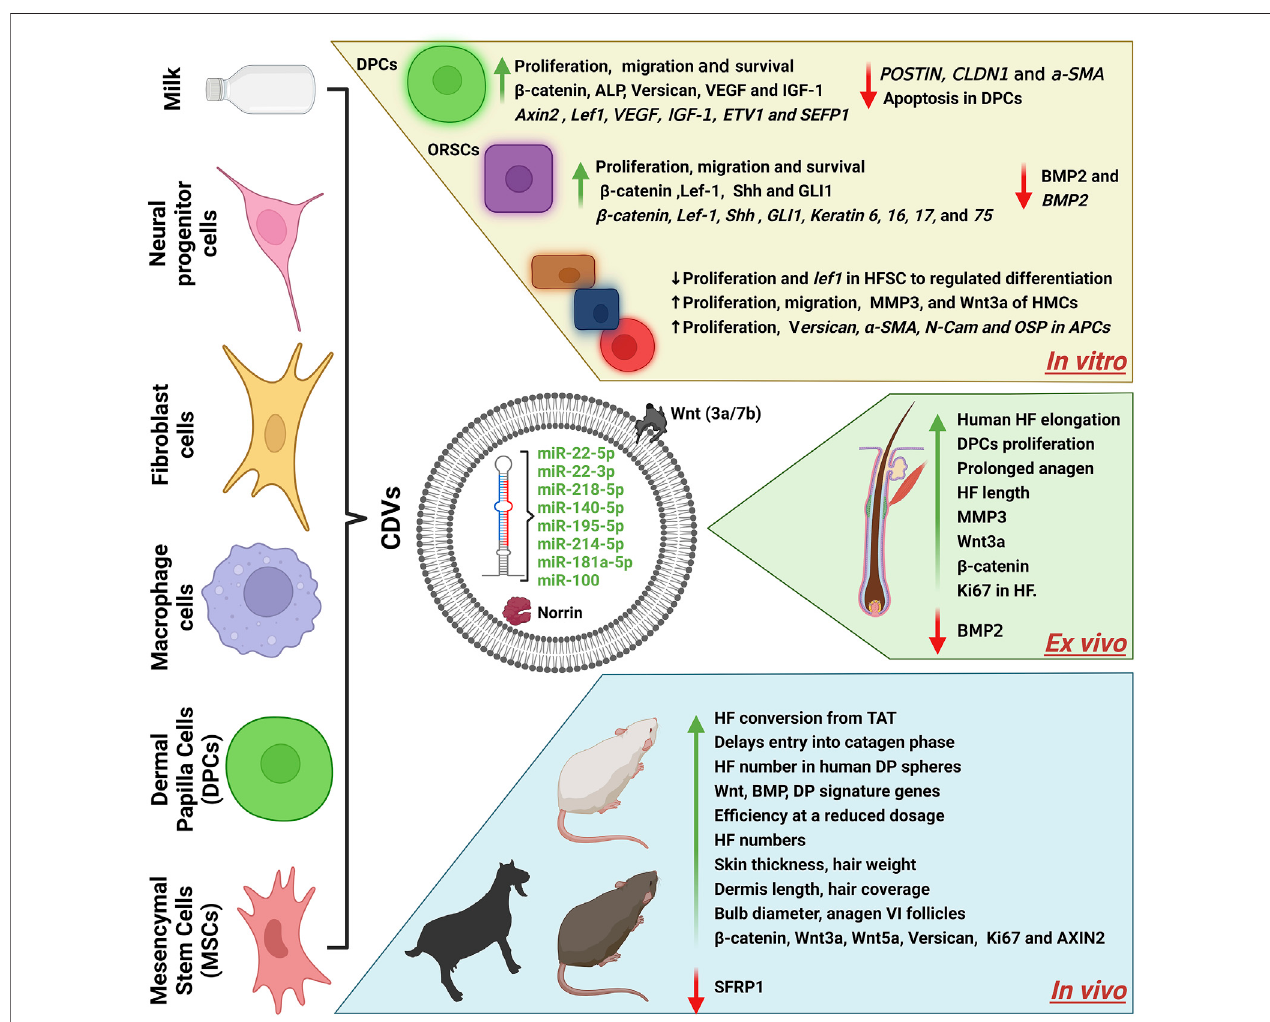
FIGURE4| Aschematicsdiagramofcell-derived nanovesiclesforhair growth.Thecargoes(miRNA/proteins)ofCDVsand theireffects invitro , exvivo ,and invivo . CDVs, cell-derived nanovesicles; BM-MSCs, bone marrow derived mesenchymal stem cells; DPC, dermal papillae cells; HF, hair follicles; HFSCs, hair follicle stem cells; ADSCs, adipose-derived stem cells; ORSCs, outer root sheath cells; HMC, hair matric cells; TAT, telogen to anagen transition; VEGF, vascular endothelial growth factors; IGF-1, insulin growth factors; Shh, sonic hedgehog; Lef-1, lymphoid enhancer binding factor 1; ETV1, ETS variant transcription factor 1; α -SMA, alpha- smoothmuscleactin;MMP3, matrixmetallopeptidase3;Wnt3a, Wntfamilymember 3A;BMP2,bonemorphogeneticprotein 2;ALP,alkaline phosphatase; AXIN2,axis inhibition protein 2; GLI1, GLI family zinc fi nger 1; SFRP2, secreted frizzled related protein 2. Created with BioRender.com.